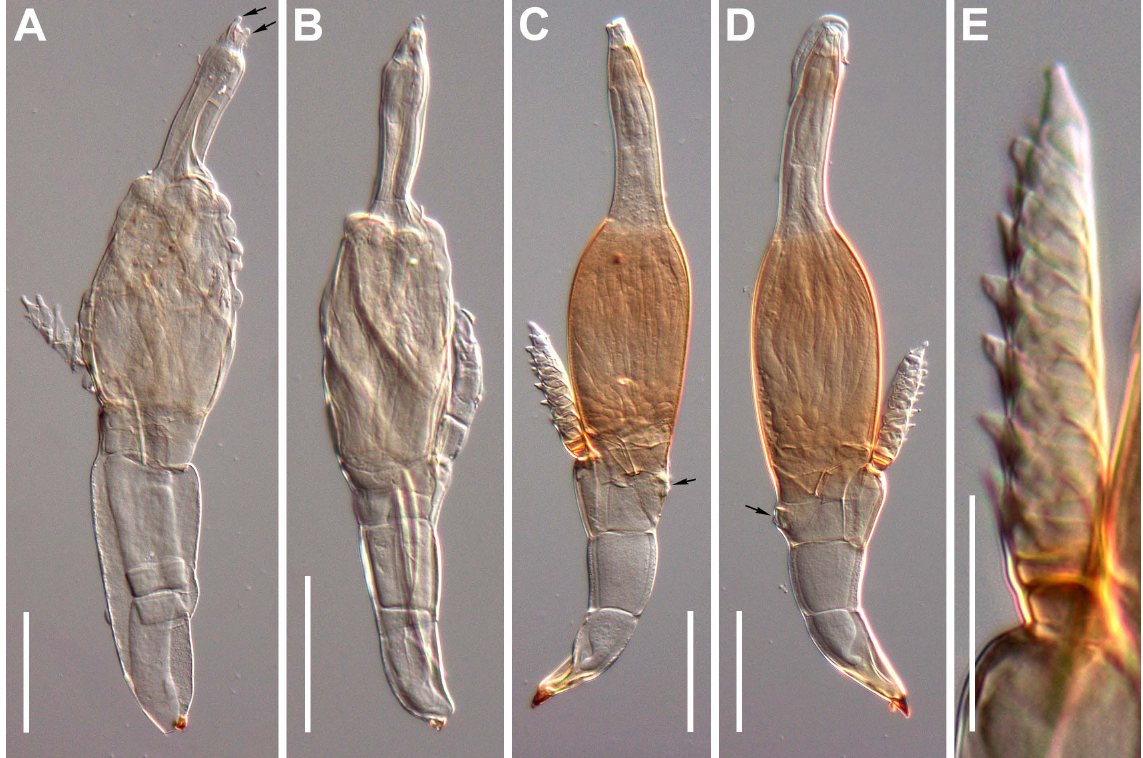
Fig. 61. Stigmatomyces spp. A – B . S. purpureus Thaxt. Mature thalli. In A, arrows point to the